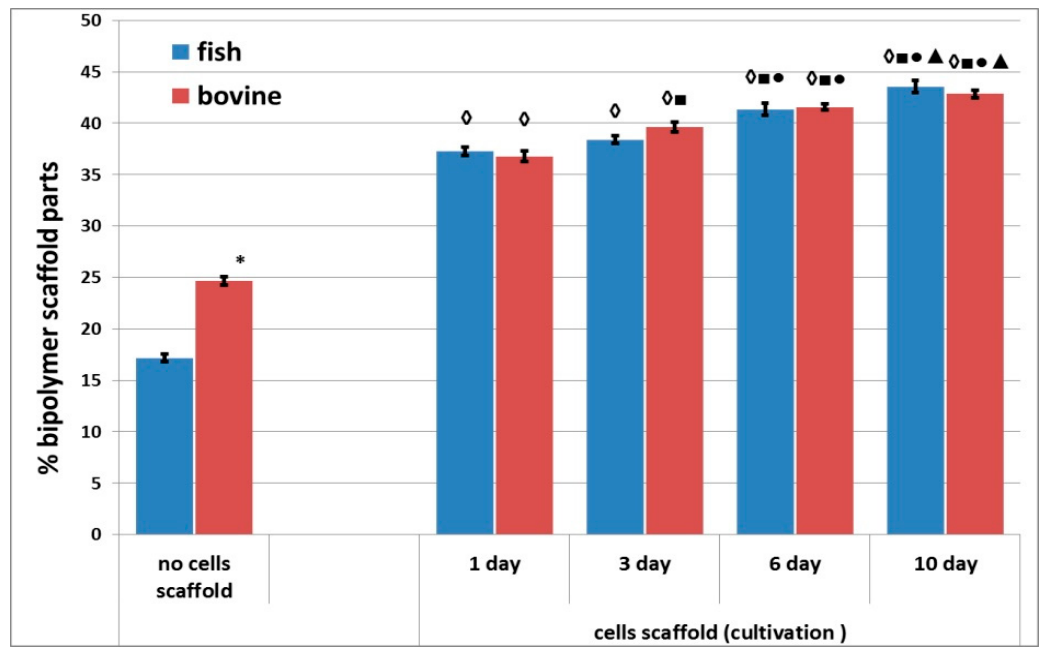
Figure 7. Density of the structure of acellular and cellular scaffolds during cultivation. Note: “Fish” means scaffolds with fish collagen, “bovine”—scaffolds with bovine collagen.*— p < 0.05 comparison of acellular bovine collagen scaffolds with acellular fish collagen scaffolds; ◊ — p < 0.05 comparison of acellular scaffolds; ■ — p < 0.05 comparison with Day 1; ● — p < 0.05 comparison with Day 3; ▲ — p < 0.05 comparison with Day 6.